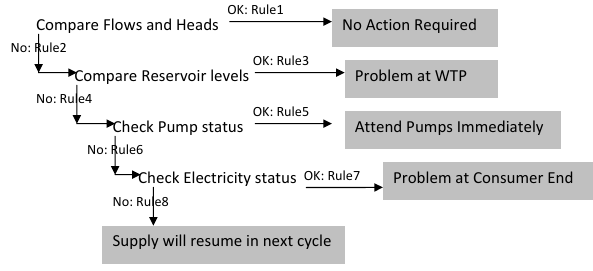
Figure 10. Working of CLIPS for Sub-Module Fig. 10. Working of CLIPS for Sub-ModuleII